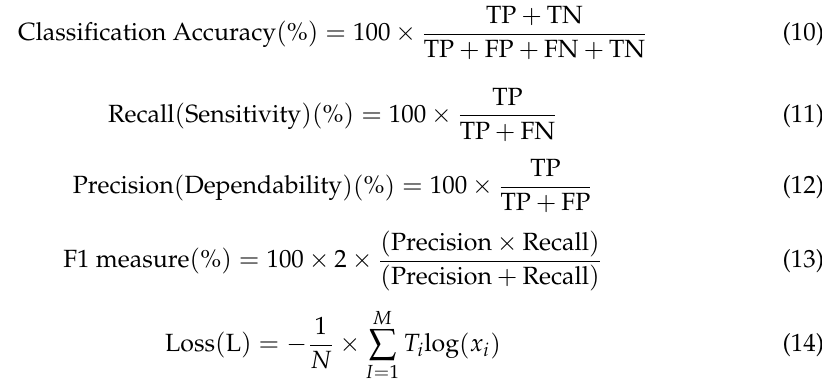
Predictive Arcing Findings (0)